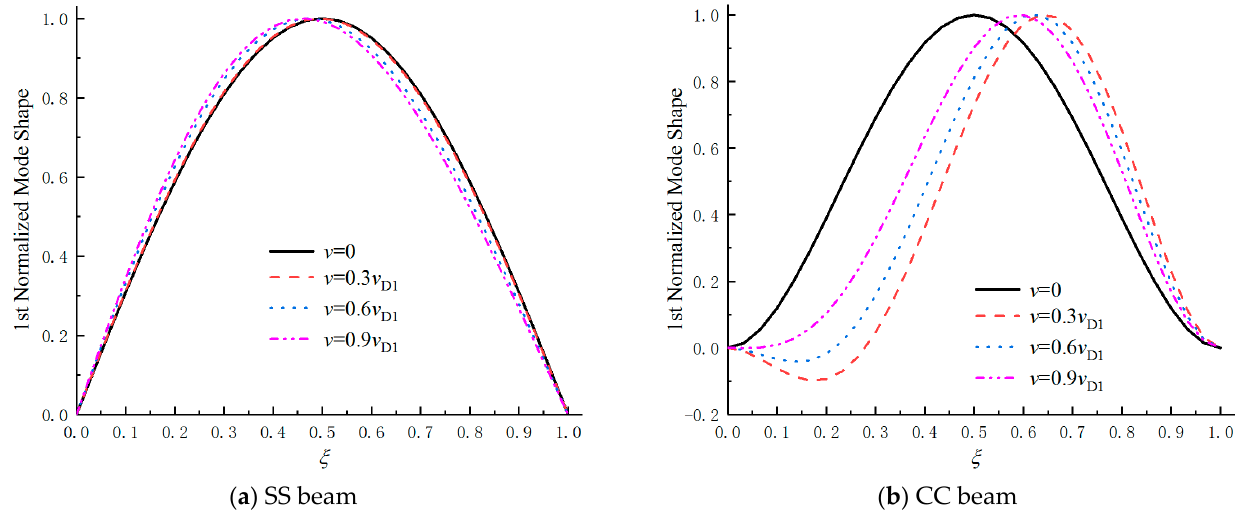
Figure 6. Real part of the first mode of FGM beam under different axial velocities.